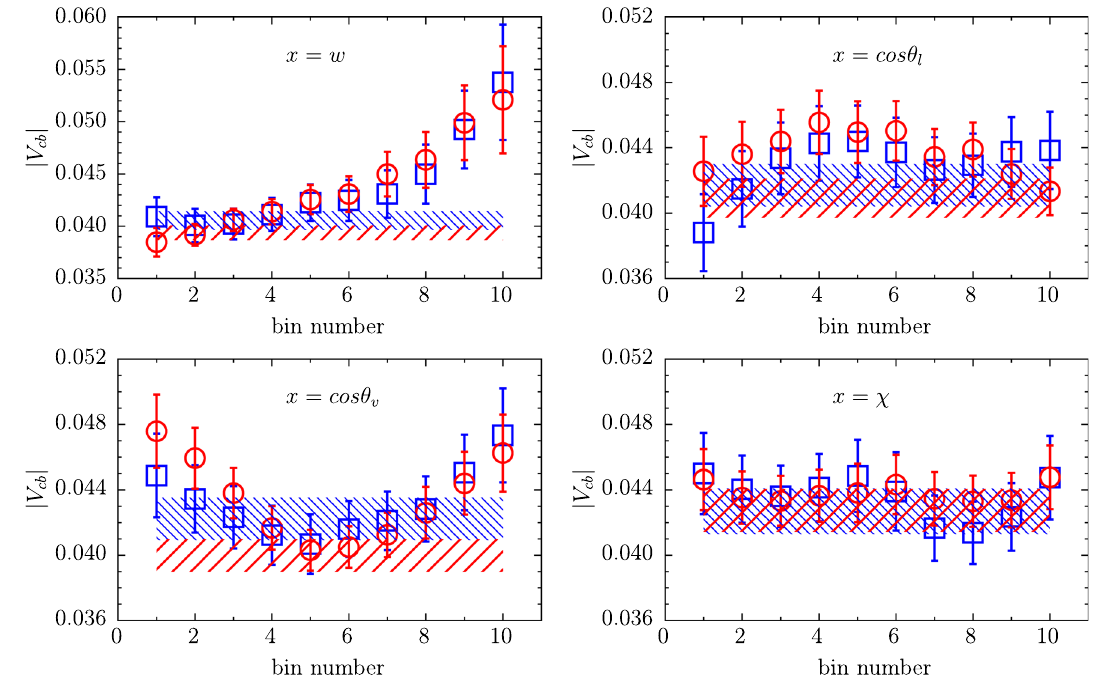
Fig. 3 The same as in Fig. 2, but using the new experimental covariance matrices described in the text Table 2 The same as in Table 1, but using the new experimental covariance matrices described in the text